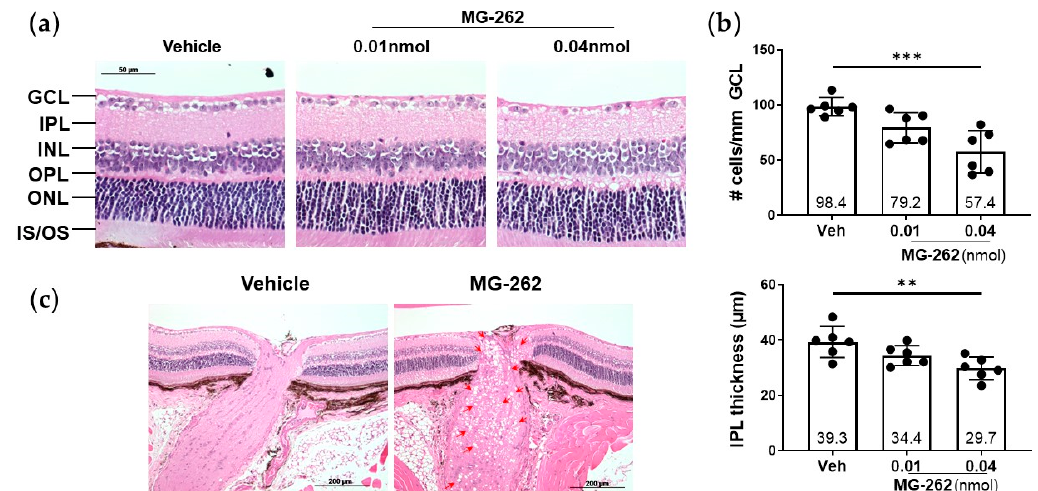
Figure 1. Proteasome inhibitor (MG-262) induced inner retinal degeneration in mice. ( a ) Representative images of hematoxylin and eosin staining of mouse retinae 7 days following intravitreal injection of 0.01 and 0.04 nmol/eye of MG-262, or its vehicle (10% dimethyl sulfoxide in Dulbecco’s phosphate buffered solution or D-PBS). Retinae were cross-sectioned, and their images were taken approximately 300 µm away from the optic nerve head. GCL: ganglion cell layer; IPL: inner plexiform layer; INL: inner nuclear layer; OPL: outer plexiform layer; ONL: outer nuclear layer; IS/OS: photoreceptor inner and outer segments. The scale bar shows 50 µm. ( b ) Quantification of number of cells in the GCL and IPL thickness meas- urement. Cell counting and thickness measurement were performed on ImageJ. N = 6 eyes from 3 mice per each treatment group. Each value represents the mean ± standard deviation with the mean value indicated at the bottom of each bar. Statistical analysis was performed with one-way analysis of variance, followed by Dunnett’s post hoc test. ** p < 0.01 *** p < 0.001, vs. vehicle (Veh). ( c ) Representative images of the optic nerve of eyes, injected with 0.01 nmol/eye of MG-262. Vacuolation (red arrow heads) was observed throughout the optic nerve in eyes injected with MG-262. The scale bar shows 200 µm.